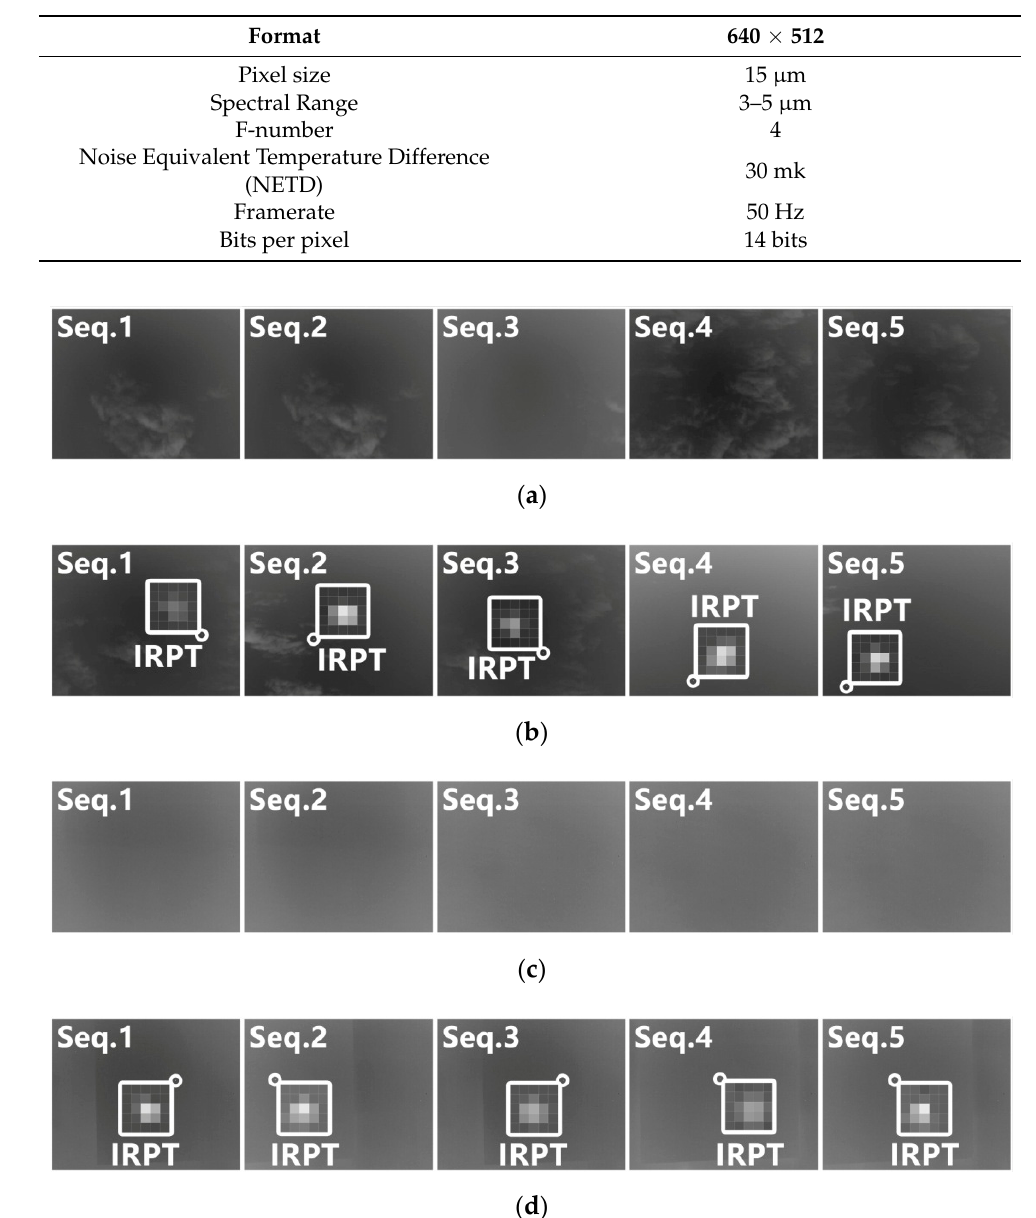
Table 2. Specifications of the MWIR detector used to obtain experimental data.